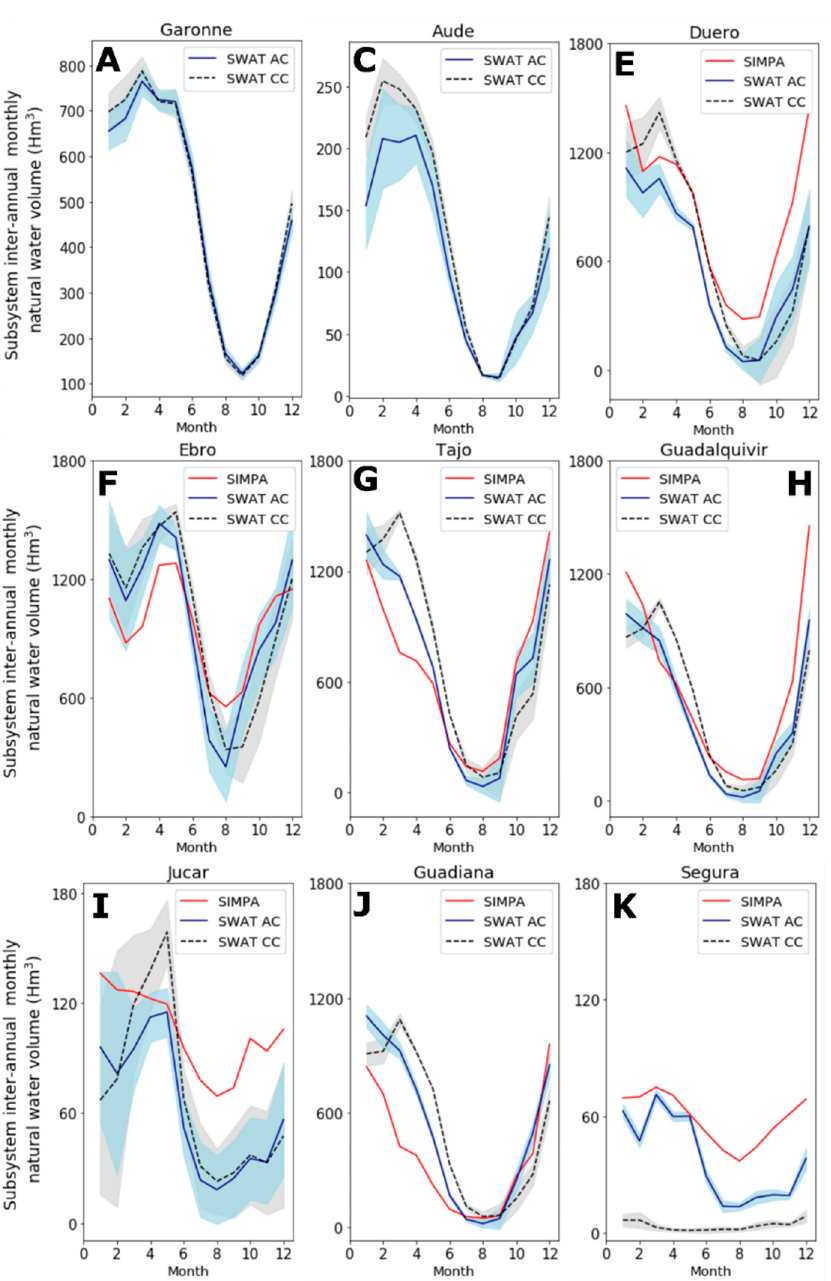
Figure 8. Inter-annual monthly dynamics of “natural” water volumes in the main SUDOE watersheds simulated with SIMPA (red line), SWAT additional calibration (SWAT AC, blue line) and SWAT conventional calibration (SWAT CC, dotted dark line). The color ribbons (blue for AC and gray for CC) show the 95% prediction uncertainty intervals resulting from the best SWAT-CUP simulation. The letters ( A , C , E – K ) indicate the watershed localization over SUDOE territory (Figure 2) (inter-annual averages from 2000 to 2010). There is no SIMPA simulation for Garonne and Aude watersheds.